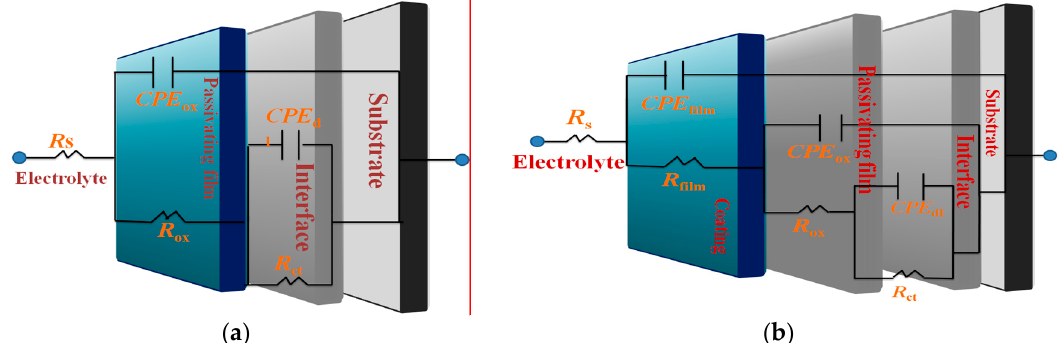
Figure 11. Equivalent circuits used for fitted experimental EIS data of RE coated metallic substrates. ( a ) bare substrates ( b ) coated specimens.